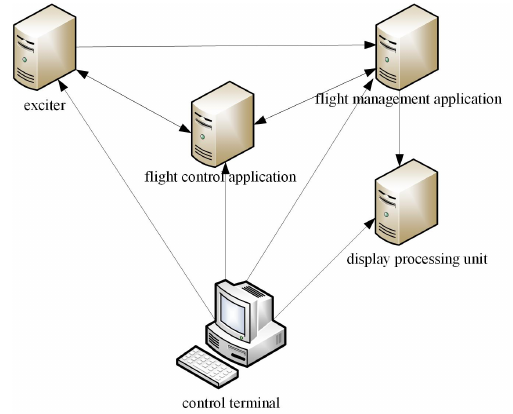
Figure 9. Interaction between